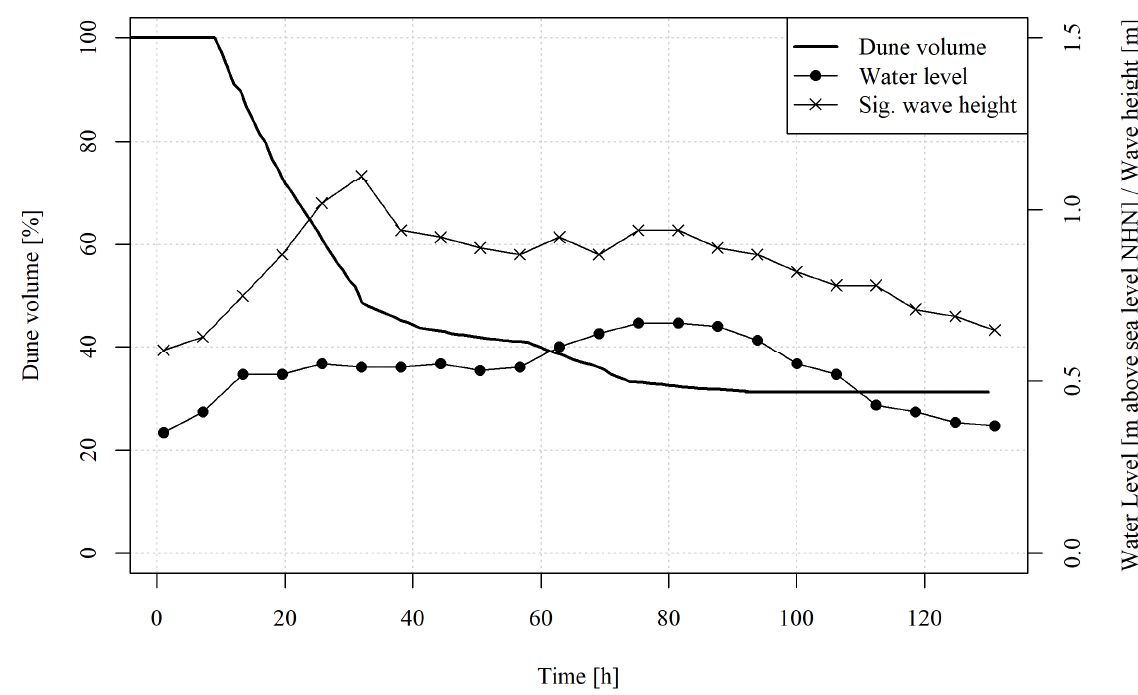
Figure 12. Temporal development of the dune volume in comparison to the water level and wave height.